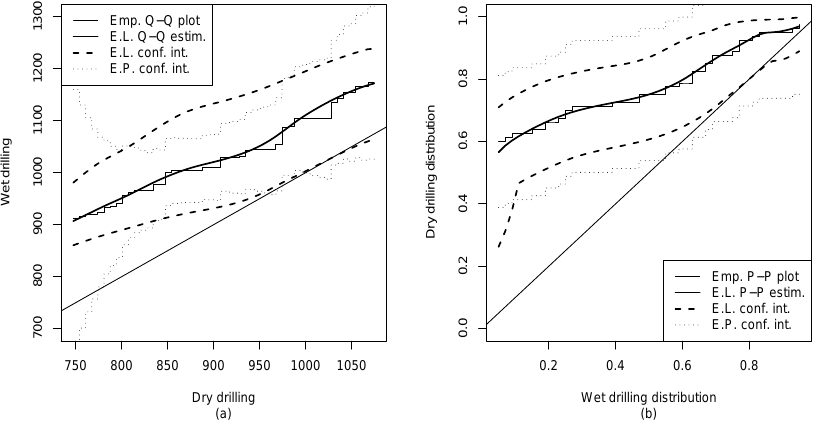
Figure 2. Q − Q (a) and P − P (b) plots of dry drilling versus wet drilling. The plots show the empirical versions together with the smoothed empirical likelihood estimates. Two types of simultaneous 95% confidence bands were constructed using empirical likelihood and empirical processes combined with the bootstrap methods described in Section